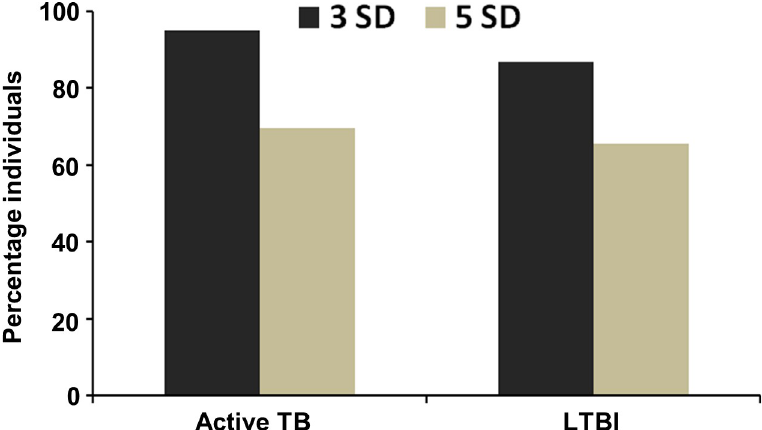
Fig 2. PPE17 is more sensitive to detect active TB and LTBI individuals. The percentages of high-level responders (samples showing antibody levels greater than or equal to the cut off values) shown in Fig 1A were calculated using a standard cut off value (mean OD 492 of the QFT-negative sera plus 3 SD or 5 SD) for active TB and LTBI individuals.